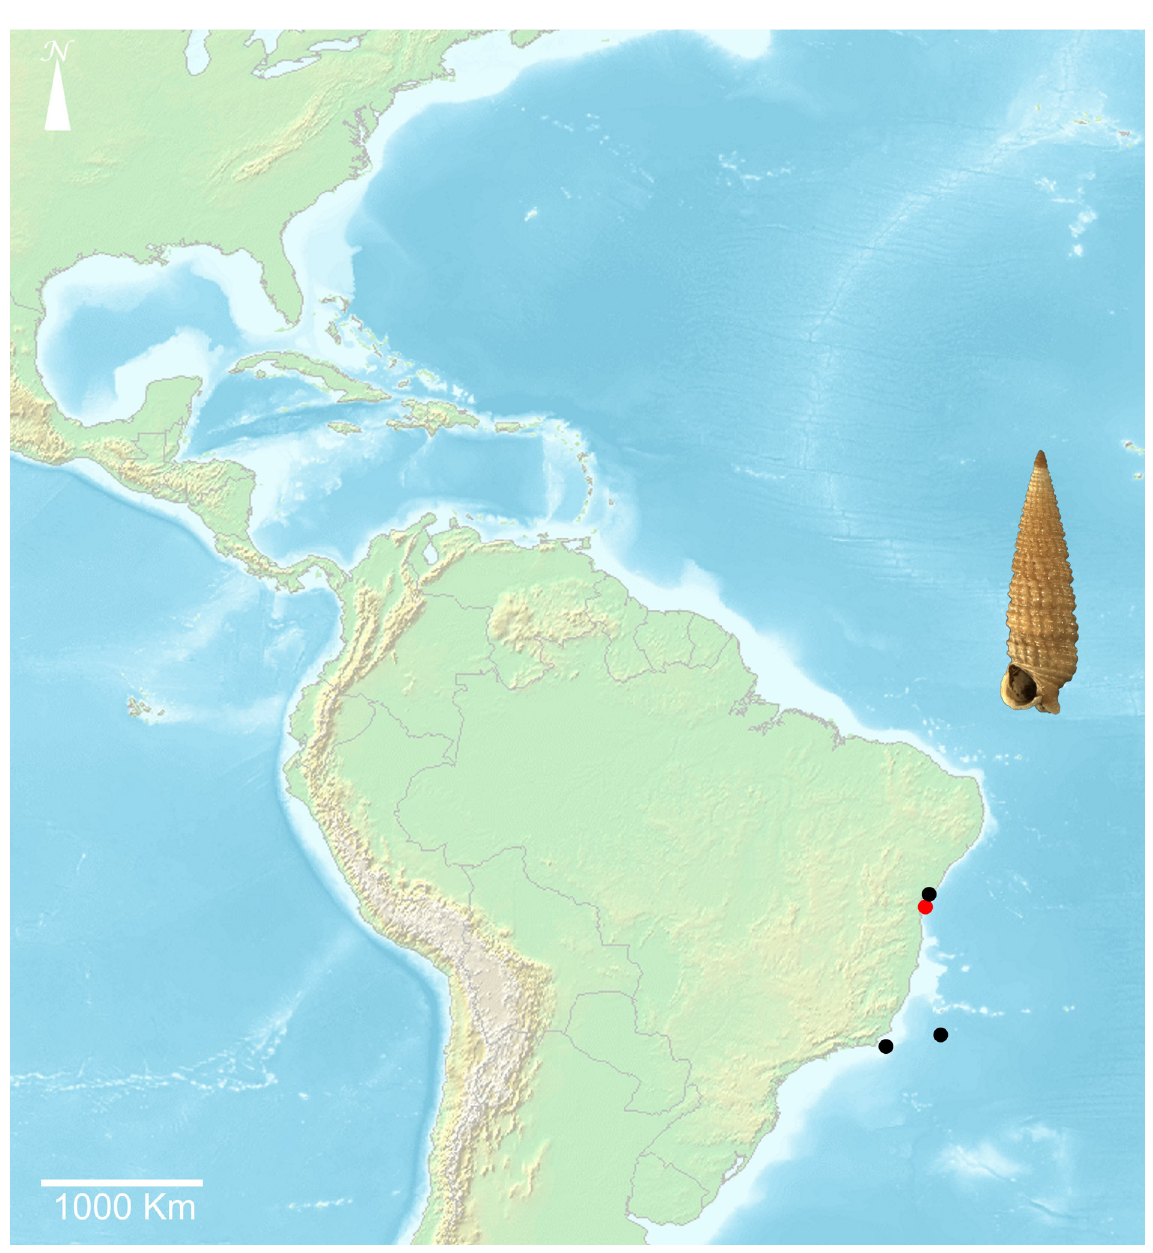
Fig. 34. Distribution map of Eutriphora costai Fernandes & Pimenta, 2015; red circle = type